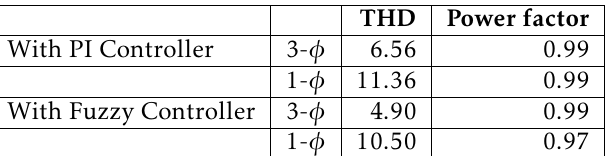
Figure 18. Active Power and Reactive Power of Load DG system at t=0.15s, it was maintained at 48000W, 500VAR showing injection of power.